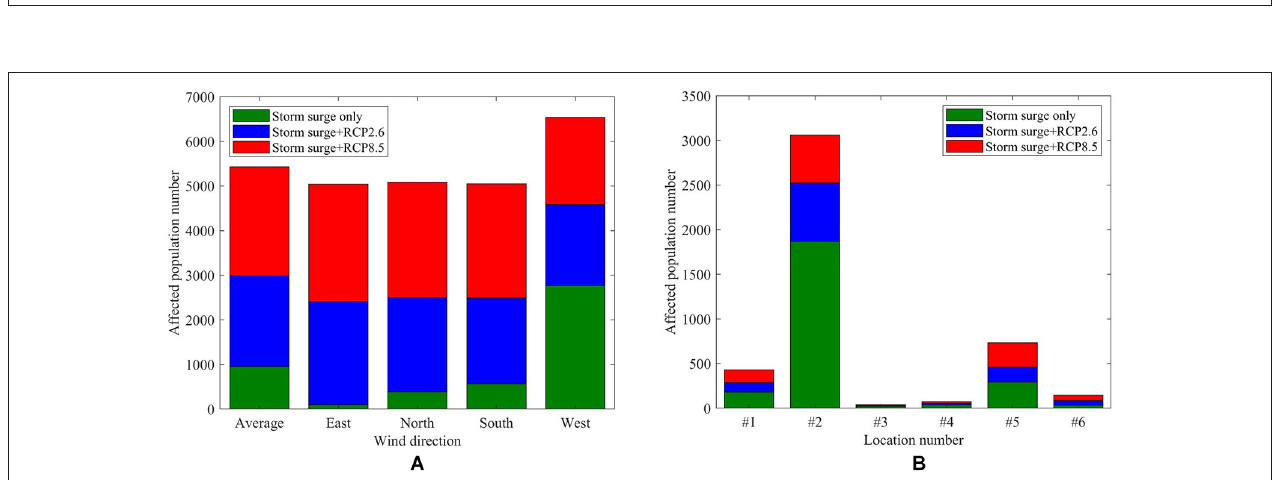
FIGURE 13 | Graphs showing the directly affected population scope trends under different wind directions (A) and in different selected locations (B) .